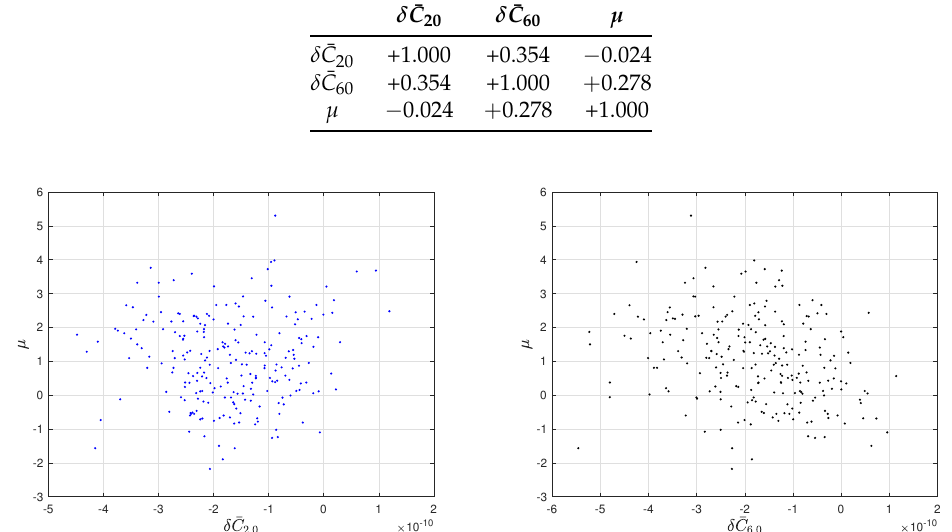
Figure 16. Correlation plots between the LT parameter µ and the corrections to the first and third even zonal harmonics. Left: quadrupole correction δ ¯ C 20 vs the LT parameter µ . Right: hexadecapole correction δ ¯ C 60 vs the LT parameter µ .